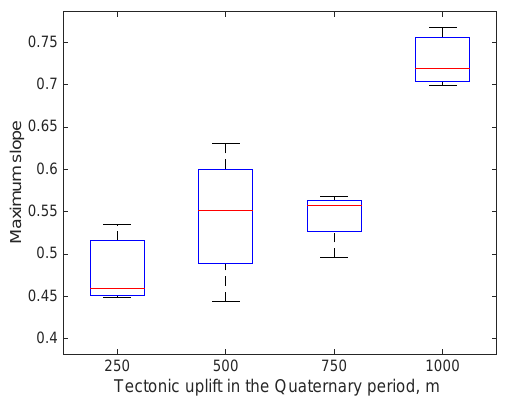
Figure 9. Tectonic uplift in the Quaternary period and maximum slope of mean slope–area